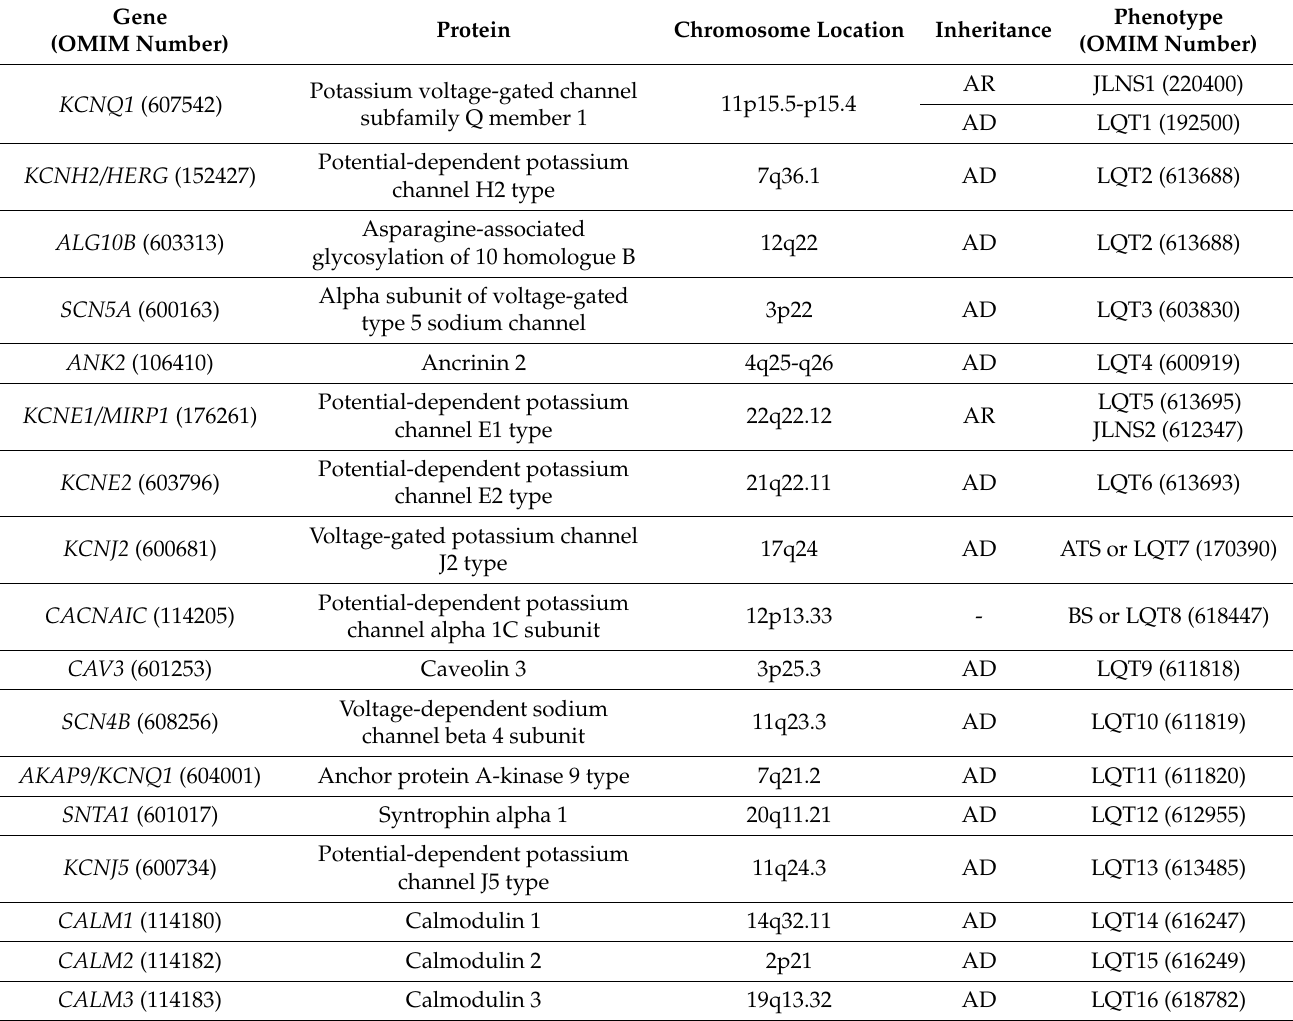
Table 1. Casual genes for monogenic long QT